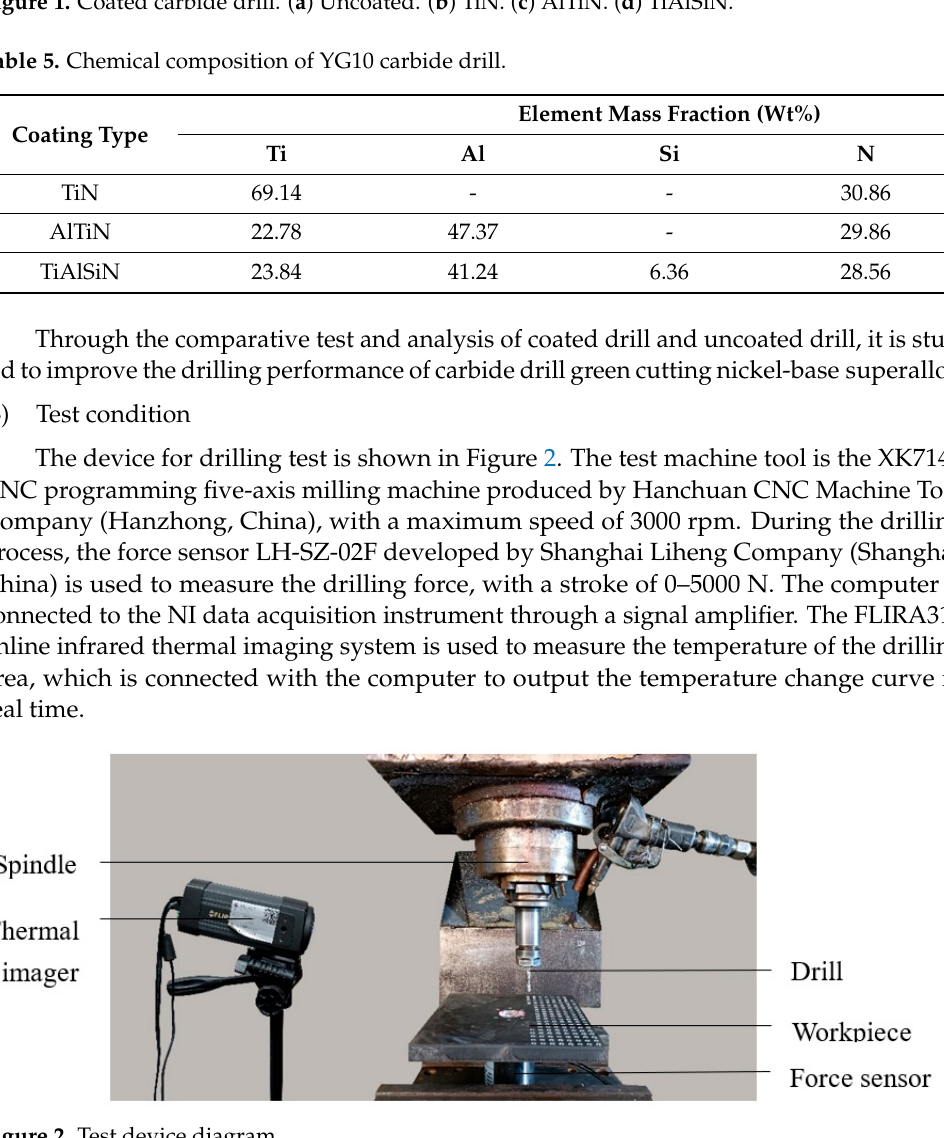
Figure 2. Test device diagram.